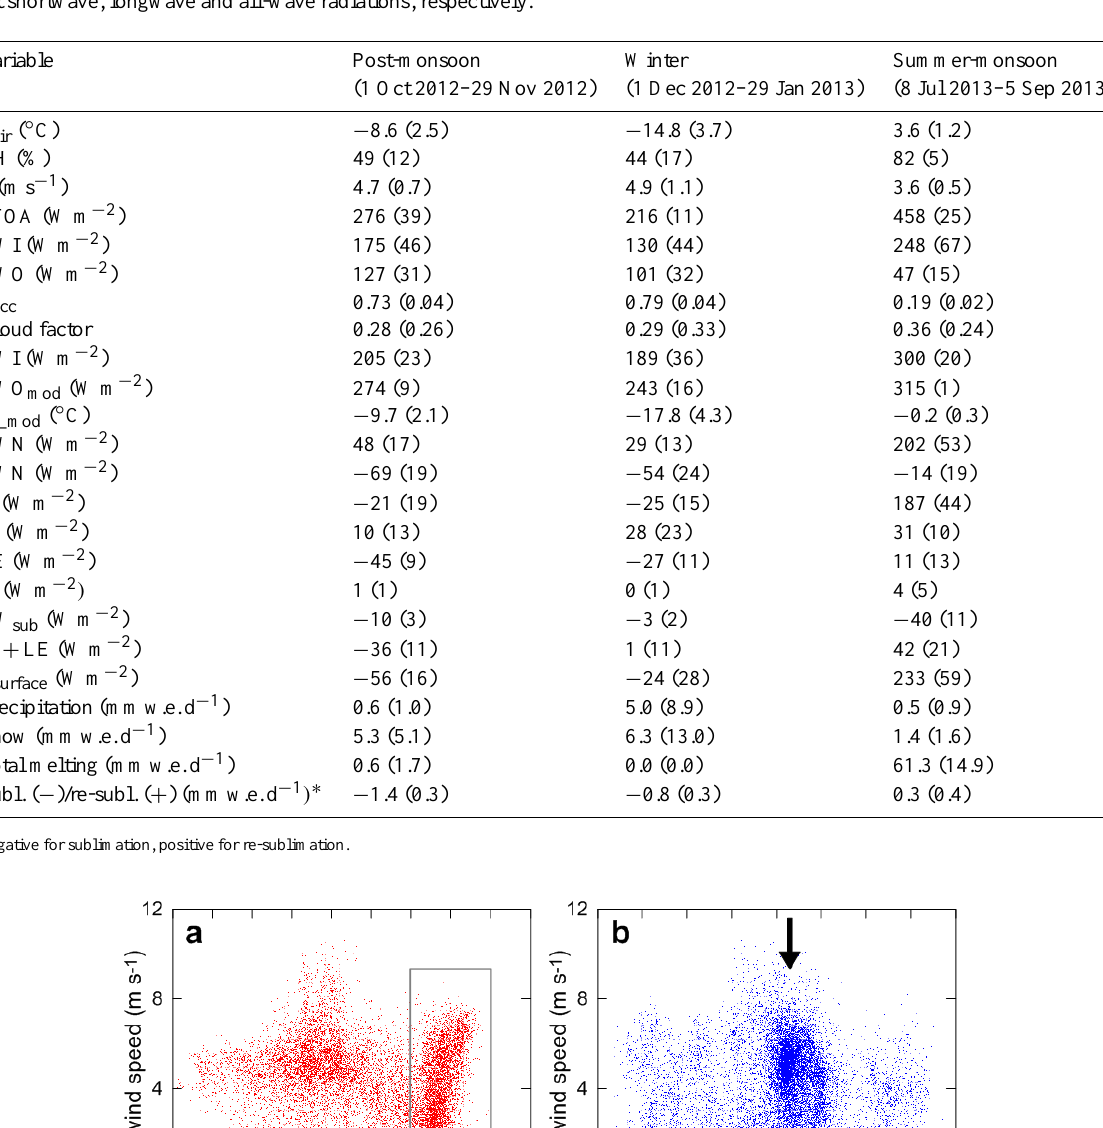
Table 3. 60-day means (standard deviations) of meteorological and SEB variables measured or computed at AWS1 (4670ma.s.l.) on Chhota Shigri Glacier for different representative periods. The symbols for variables are described either in the text or in Table 1. SWN, LWN and R are net shortwave, longwave and all-wave radiations, respectively.